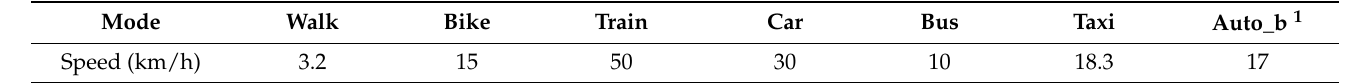
Table 4. Average travel speed by mode.